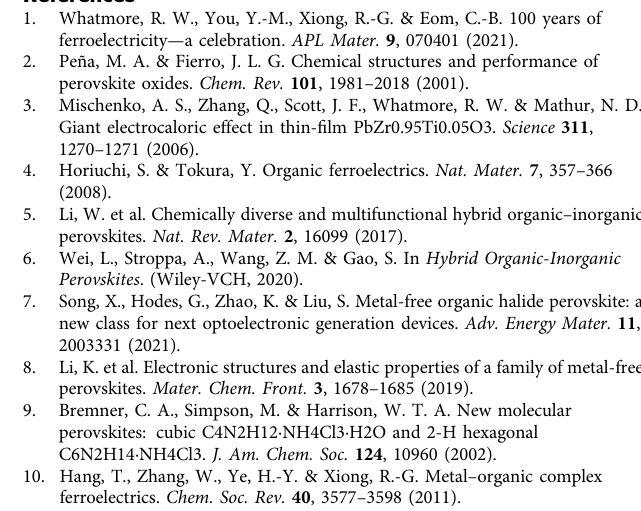
between the cation and anion can be used for the engineering of the coercive fi eld in organic ferroelectric materials.